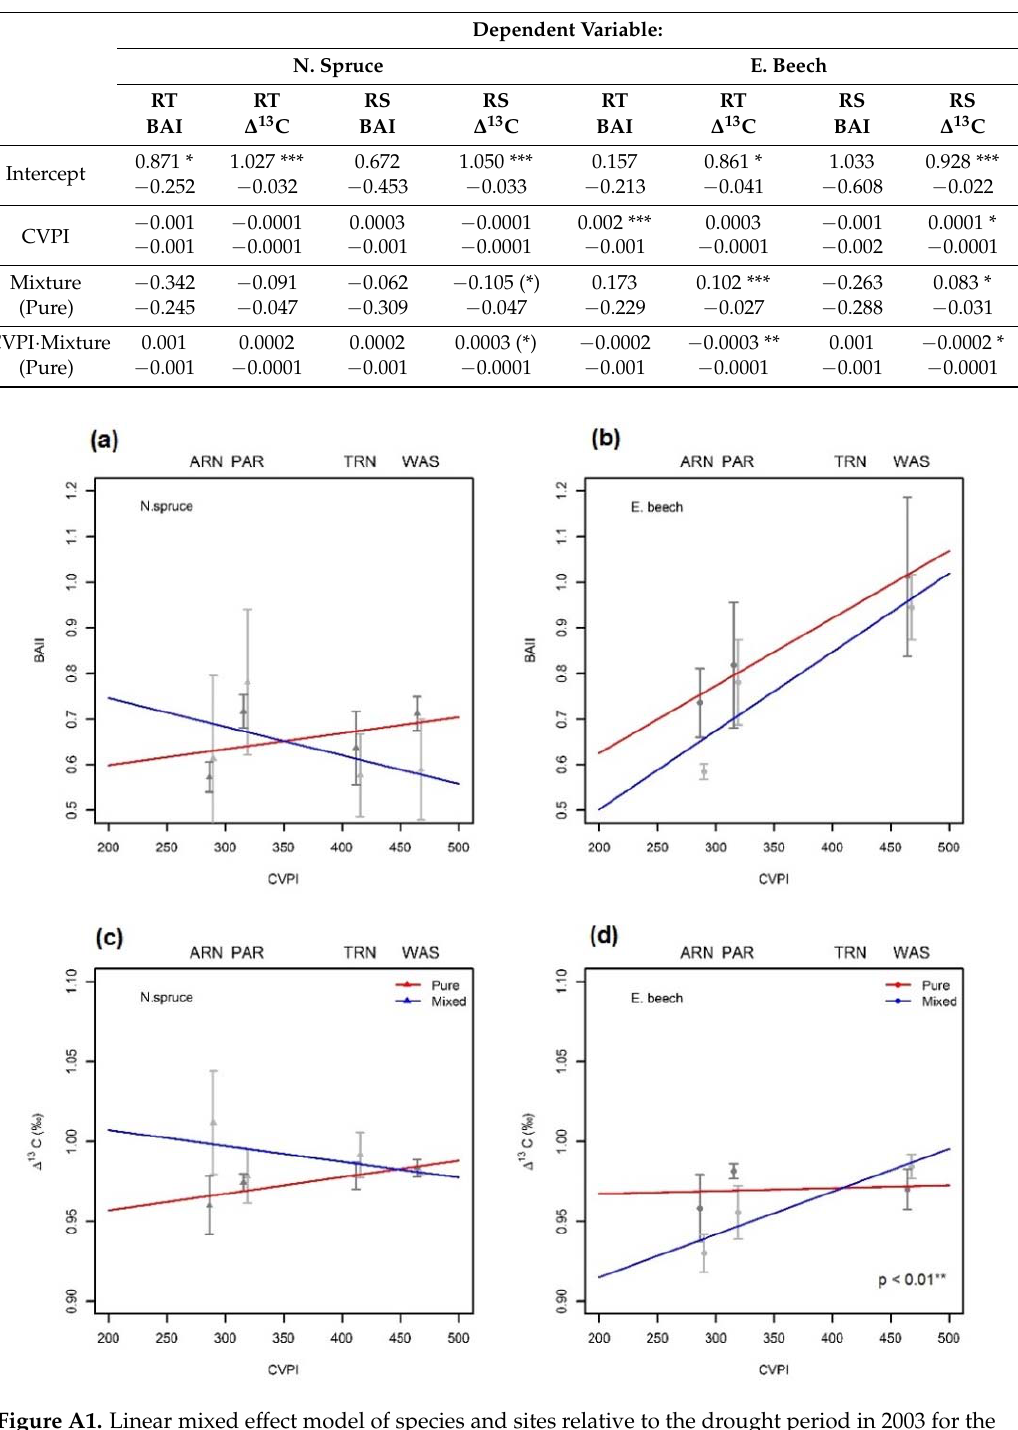
Figure A1. Linear mixed effect model of species and sites relative to the drought period in 2003 for the resistance of spruce and beech of BAII ( a , b ) and ∆ 13 C ( c , d ) in monospecific or mixed environments along the gradient represented by Paterson-index